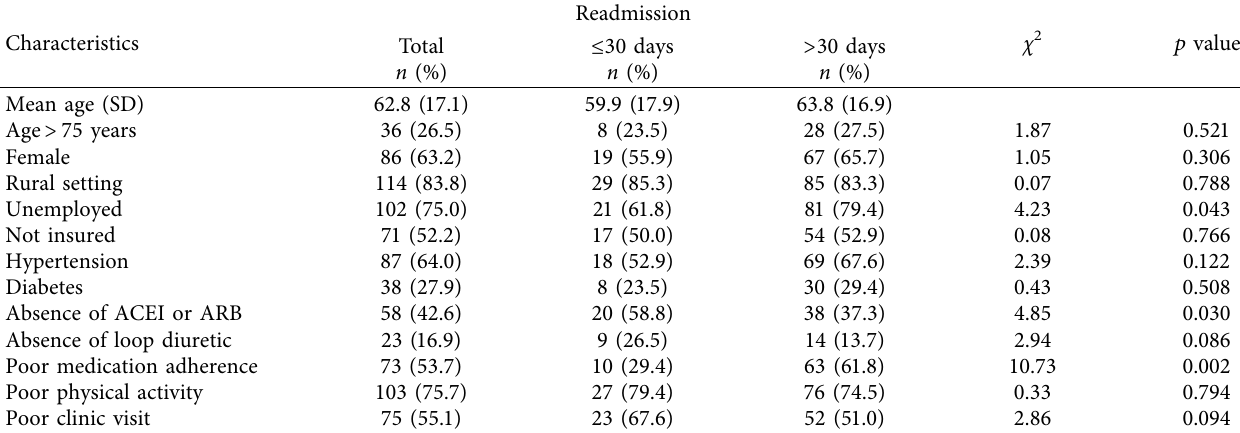
Table 1: Sociodemographic characteristics of patients readmitted for heart failure ( N � 136).